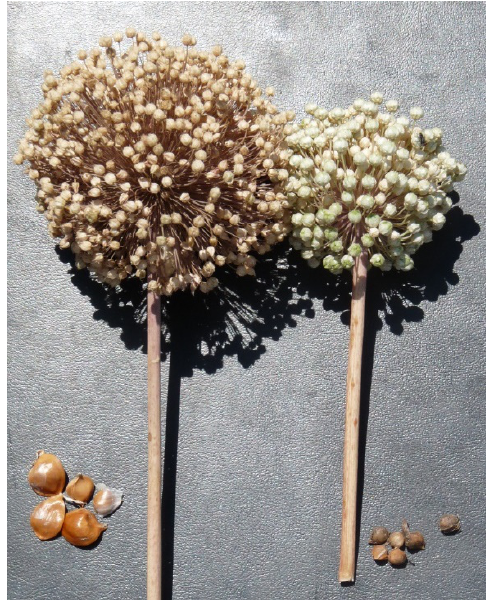
Figure 3. The two Allium ampeloprasum types differ in their mode of reproduction. Inflorescences and bulblets of both types are shown. On the left the asexual type (type II) and on the right the sexual type (type I).